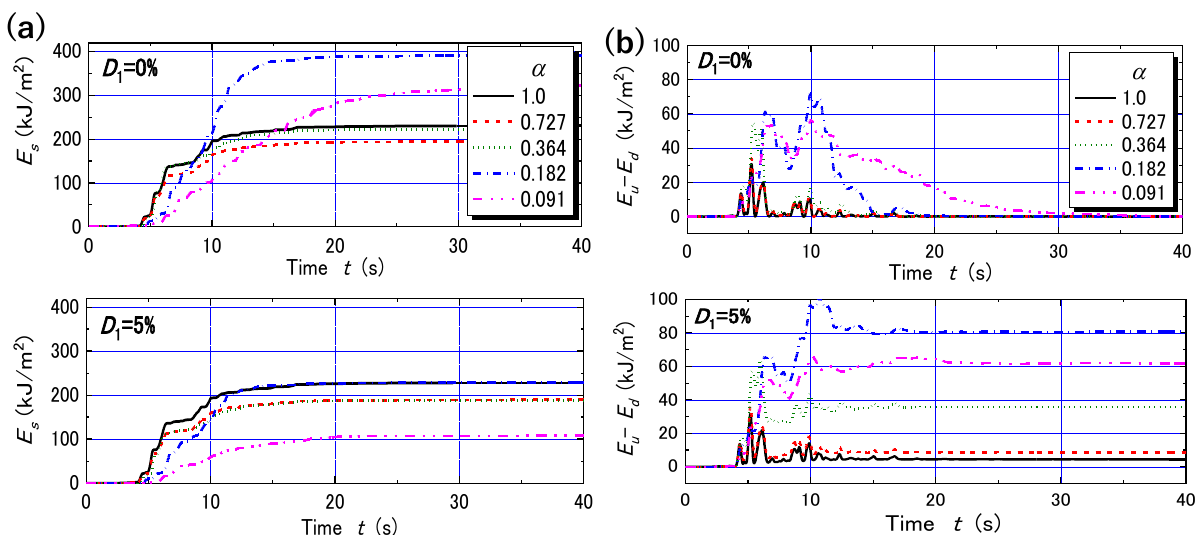
Figure 7. Time–histories of wave energies for D 1 = 0% ( top ) and 5% ( bottom ). Upward energy at ground surface E s ( a ) and energy difference E u − E d in base layer ( b ). Based on the series of similar calculations for different D 1 values, the ratios of surface energy E s to upward energy E u at the end of the earthquake motion are plotted versus the impedance ratio in Figure 8a. If D 1 = 0 or 2.5%, E s / E u > 1.0 holds for α = 0.182 or nearby, indicating that the energy is temporarily stored in the surface layer because the two-layer system with this α value is in near resonance with the input motion. For D 1 > 10%, however, E s / E u tends to be smaller than unity and decreases monotonically with decreasing α . Figure 8b shows the ratios of dissipated energy E w = E u − E d to E u at the end of the earthquake motion for different D 1 values. E w / E u tends to be larger with increasing D 1 and takes the maximum at α = 0.182 in resonance with the input motion. Thus, the energy storage effect in the surface layer near resonance is cancelled by the increasing dissipated energy E w with increasing D 1 in this model study.